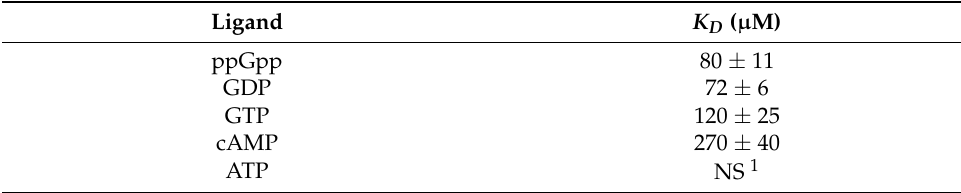
Figure 3. Determination of the dissociation constant K D for ppGpp on H-NS by fluorescence spectrometry. ( a ) The emission spectra of H-NS in the presence of ppGpp. While H-NS (10µM) was excited at 280 nm, the emission spectra in the presence of various concentrations of ppGpp were recorded at 25 °C . ( b ) The difference in fluorescence (ΔF(area)) between 322 and 336 nm against ppGpp concentrations. The K D for ppGpp was calculated as 80 ± 11 µM. Table 3. The K D ’s for nucleotide ligands on H-NS.